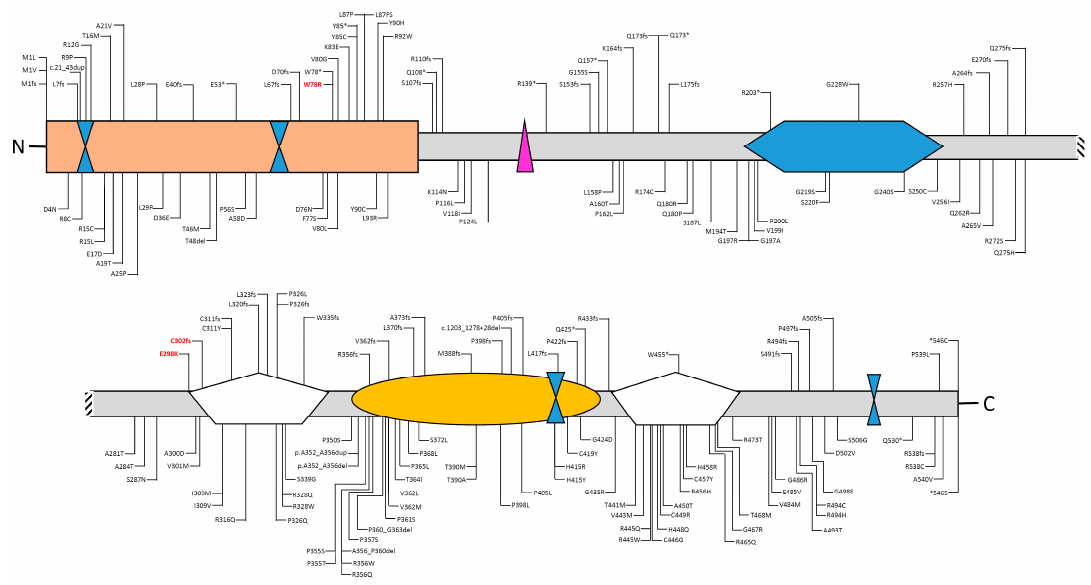
Figure 4. Deleterious (pathogenic and likely pathogenic) variants and variants of unknown significance (VUS) identified in the AIRE gene and their locations within the different domains of the protein. Deleterious variants are shown above, while VUS is below the protein structure. Data have been downloaded from ClinVar (https://www.ncbi.nlm.nih.gov/clinvar/?term=aire[gene]). Please note that large genomic deletions, benign, and synonymous variants are not shown.